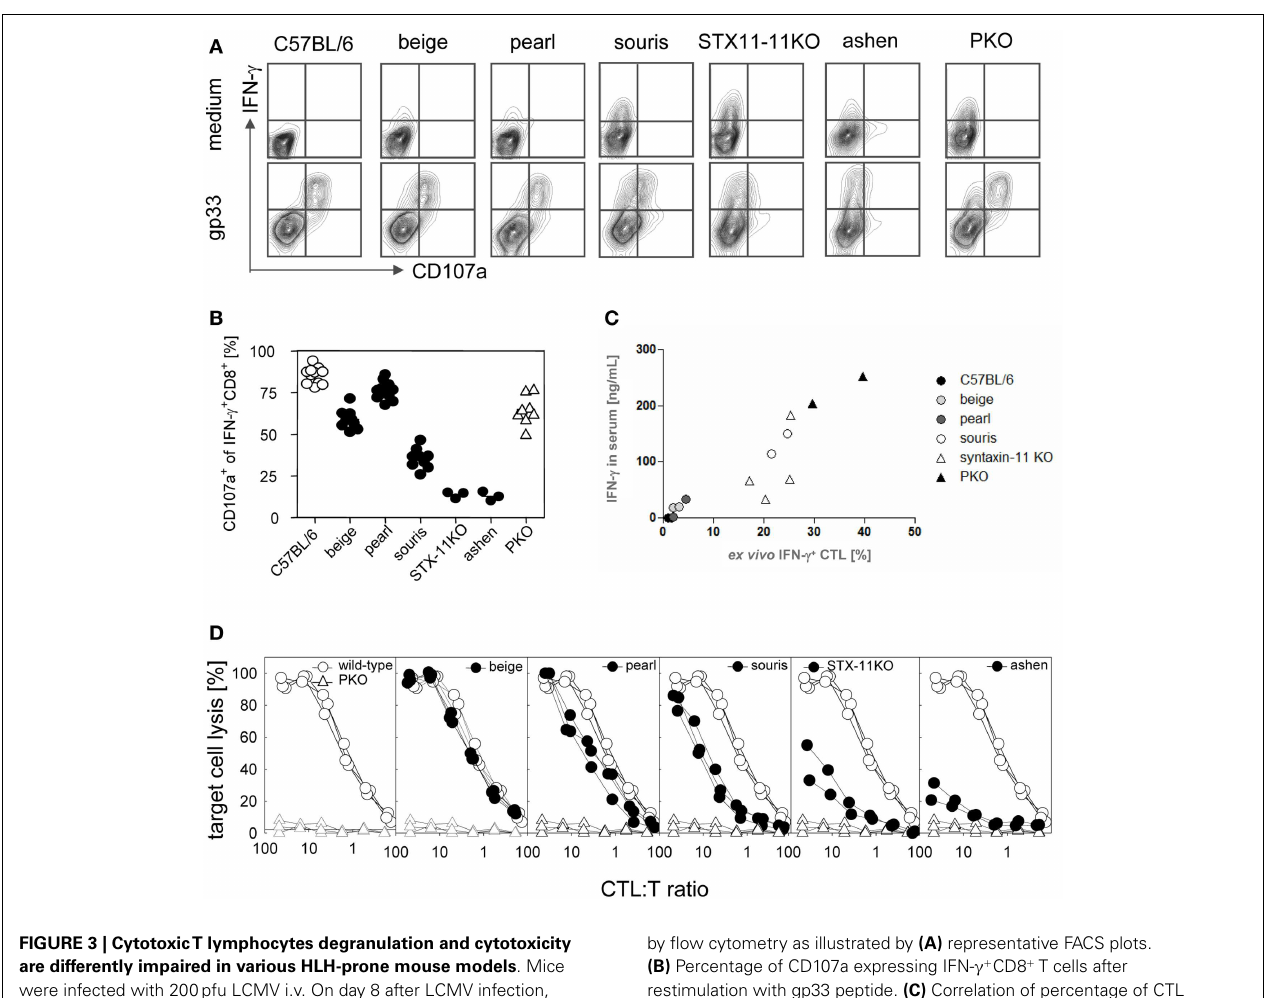
FIGURE 3 | CytotoxicT lymphocytes degranulation and cytotoxicity are differently impaired in various HLH-prone mouse models . Mice were infected with 200pfu LCMV i.v. On day 8 after LCMV infection, spleen cells of mutant mice ( beige , pearl , souris , STX-11KO , ashen /filled circles) and wild-type (open circle) and PKO (open triangle) mice were restimulated with gp33 peptide or were left in medium without peptide. Surface expression of CD107a of IFN- γ + CD8 + T cells was determined